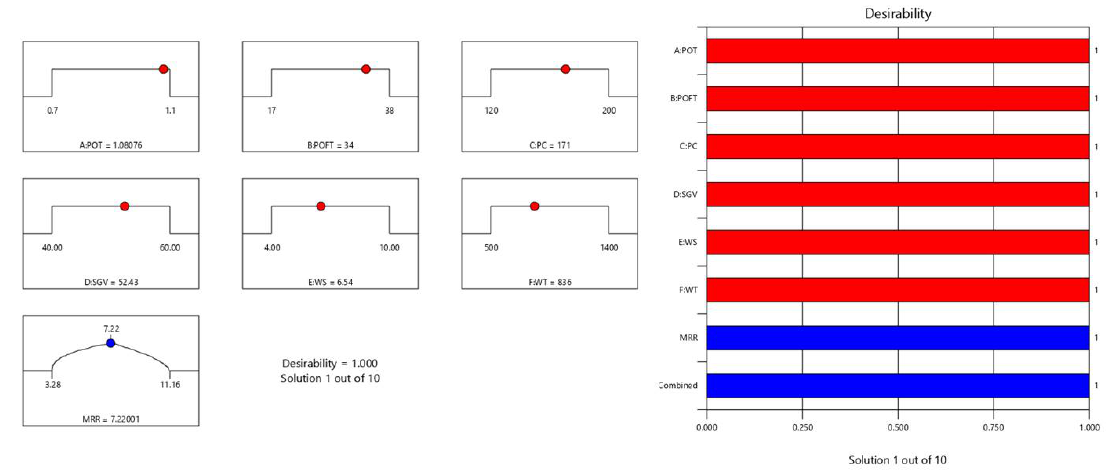
Figure 7: Desirability ramp and a bar graph (a graphical representation of numerical optimization results) for achieving optimum MRR.